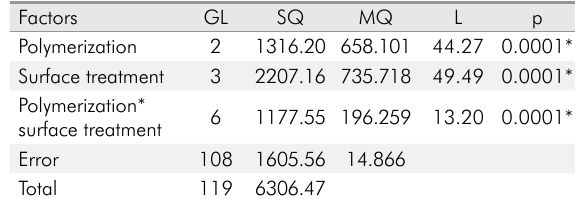
Table 2. Results of 2 factors ANOVA for the “polymerization” and “surface treatment” factors according to bond strength (*p <